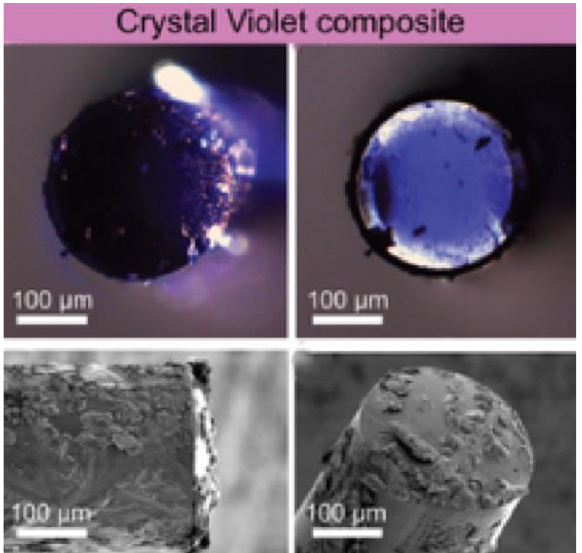
Figure 6. Images of the optical fiber’s distal end covered by crystal violet-PDMS composite. Repro- duced with permission from [61].